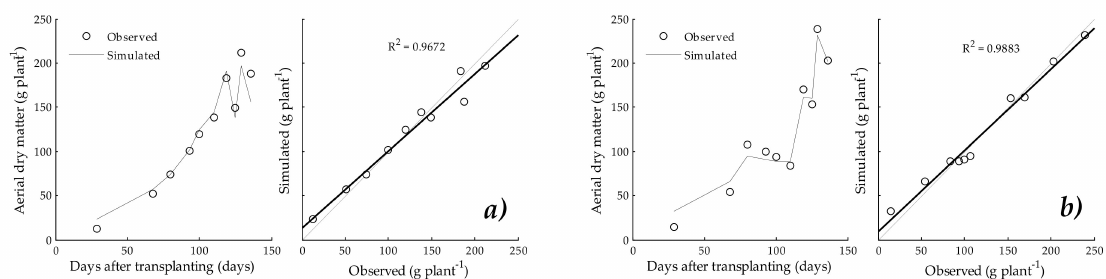
Figure 3. Aerial dry matter of the tomato plants grown in the ( a ) substrate and ( b ) soil.